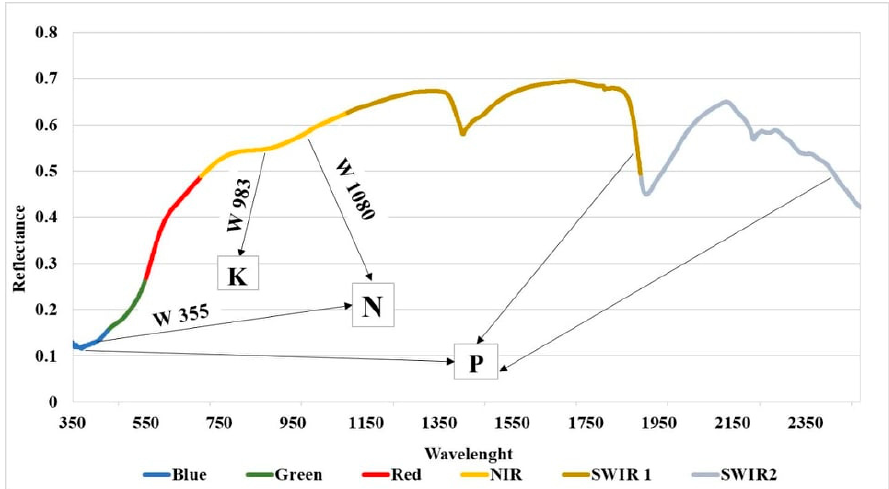
Figure 3. The spectral responses places of soil nutrients (N, P, K), each color refers to the portion of wavelength (blue, green, red, near-infrared (NIR), SWIR1, and SWIR2).